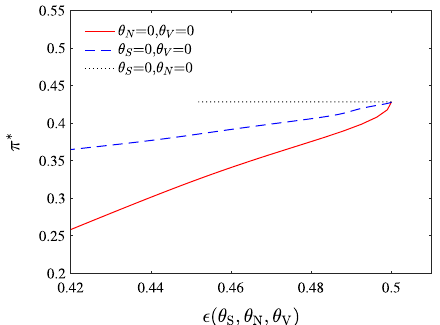
Fig. 8 Optimal portfolio choice in Bitcoin market as a function of the DEP using different θ S , θ N and θ V . The solid, dashed and dotted line represent change of ambiguity aversion with respect to price diffusion, jump and volatility diffusion while keeping the other two parameters as zero,